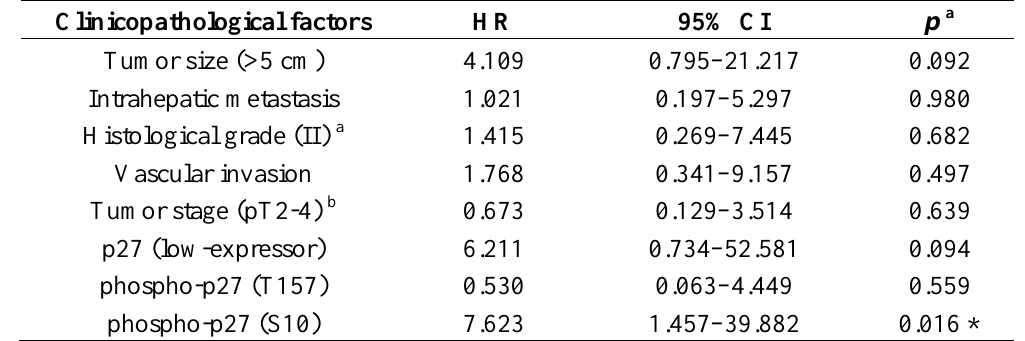
Table 4. Univariate analysis of three-years disease-free survivals for NASH-related HCC.